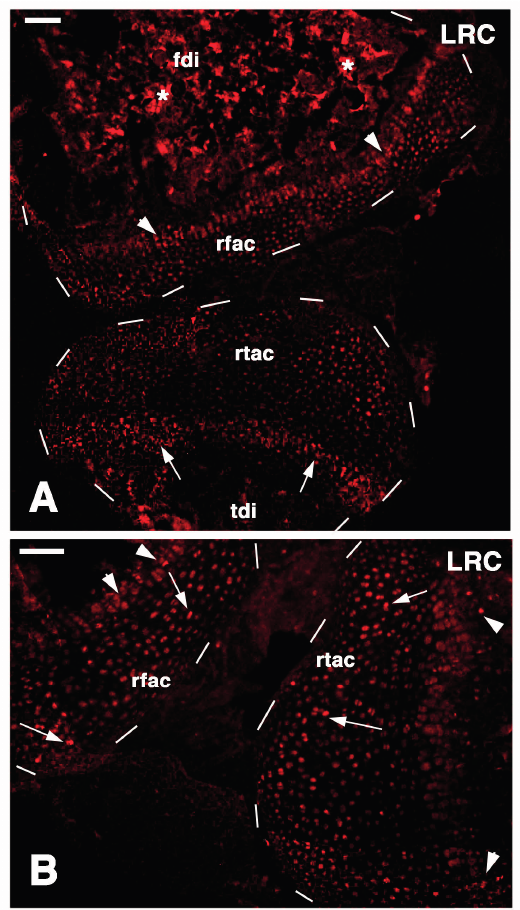
Figure 5. TRITC immunofluorescence for LRCs in regenerated cartilaginous epiphyses at four-and-a-half weeks post-injury. ( A ) General view of the regenerated cartilaginous articular cartilage of the femur (rfac) and tibia (rtac), both outlined by dashes. Sparse labeled cells are present within the cartilage and in the metaphyseal growth plates (arrowheads in femur, arrows in tibia). Asteriks indicate a non-specific labeling of the mineralized matrix in the femur diaphysis (fdi) and tibia diaphysis (tdi). Bar, 50 µm; ( B ) detail of the regenerated femur articular cartilage (rfac) and that of the tibia (rtac), for which surfaces are outlined by dashes. Sparse intensely labeled LRCs are seen within the cartilaginous tissue (arrows) and few also in the metaphyseal growth plate (arrowheads). Bar, 50